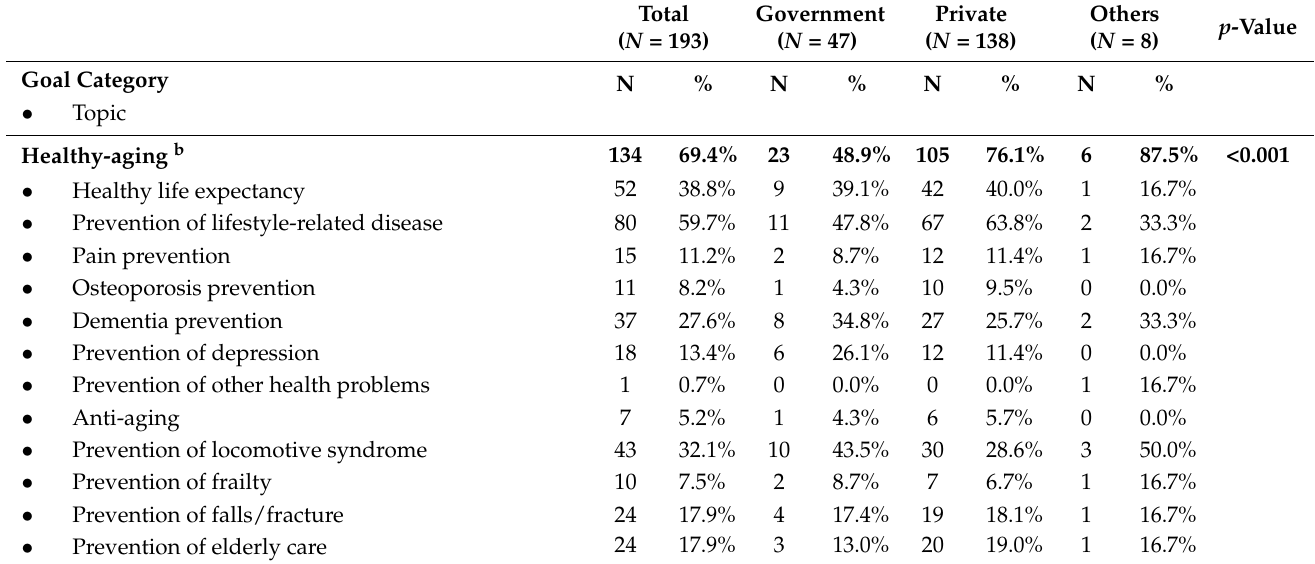
Table 3. Categories and Topics of Superordinate Goals in PA Print Materials by Publisher ( N = 193).